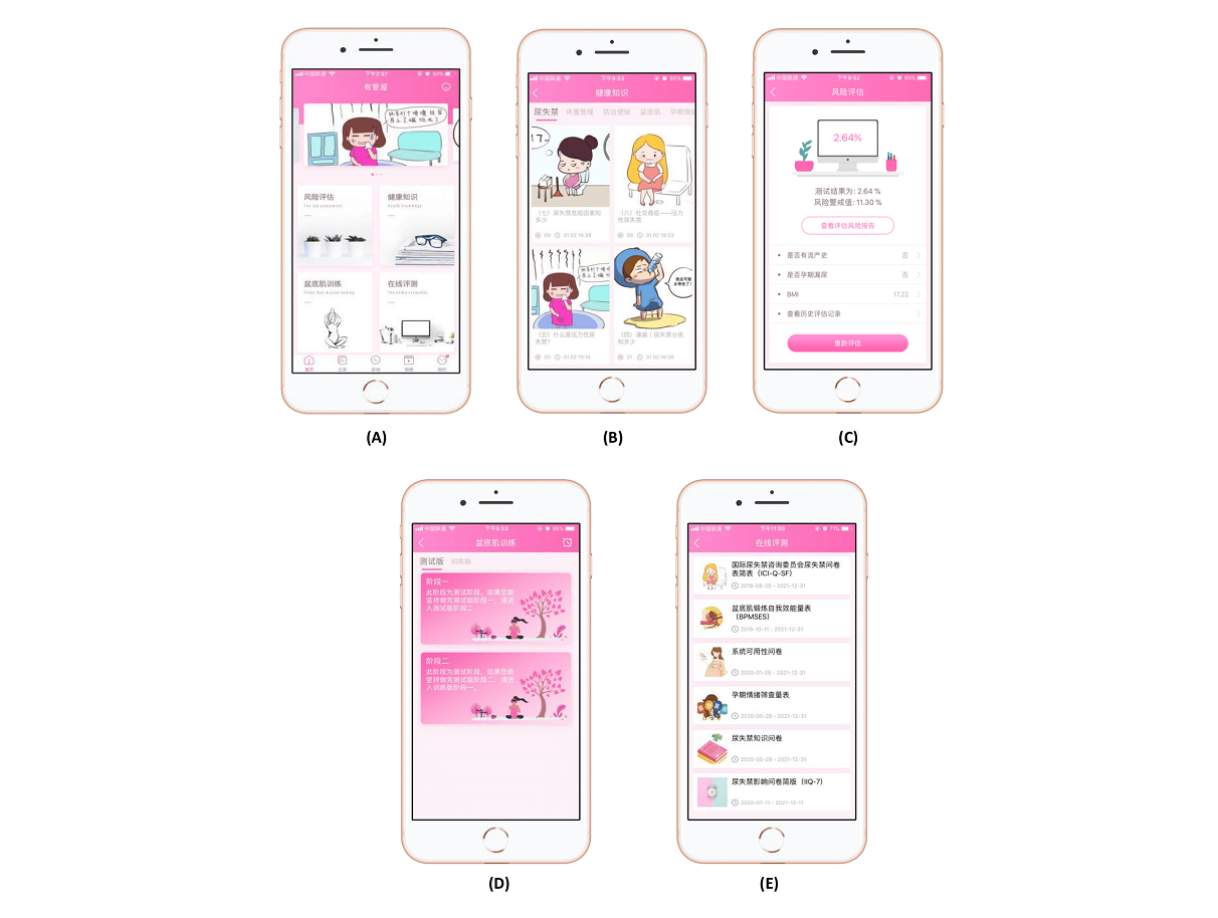
Figure 3. Screenshots of the UIW (Urinary Incontinence for Women) app, including the (A) Home Page, (B) Risk Assessment forum, (C) Health Education forum, (D) Pelvic Floor Muscle Training (PFMT) forum, and (E) Online Evaluation